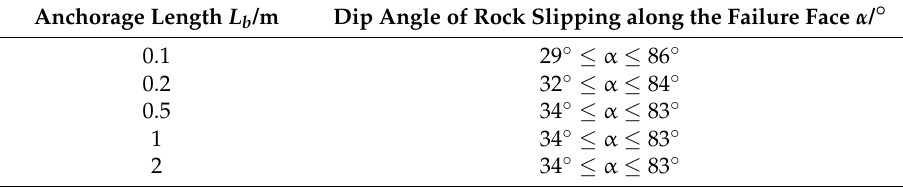
Table 2. Dip angle of rock slipping along the failure face AB with different anchorage lengths.